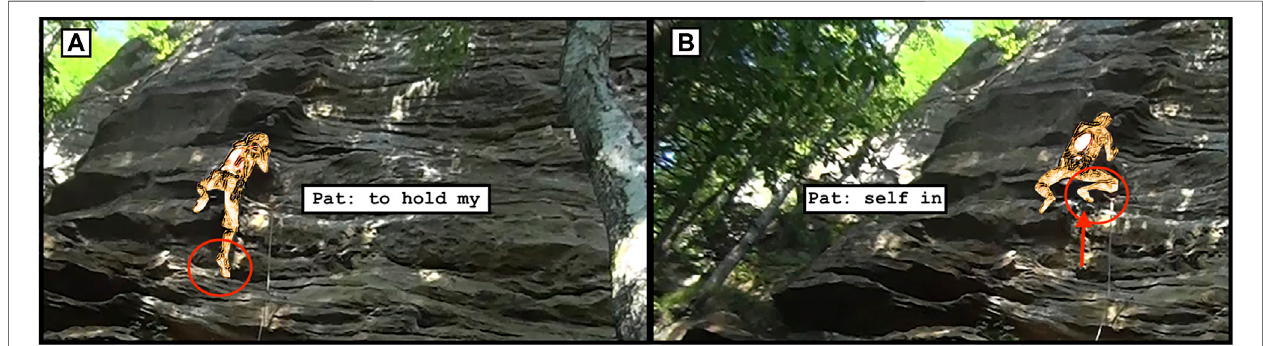
FIGURE 2 | As Pat lifts his foot, he suspends the ongoing word (or noun phrase), completing it (de fi nitively making it a word) once his foot is secure. The fi gure shows the difference in position from the opening moment of suspension (A) to the moment of resumption (B) . If the reader attempts this movement (put one leg half bent on a chair, try to stand up without kicking off, and have someone around to prevent falls), they will fi nd they tense many torso muscles as they lift their second leg and foot into the crouch and may hold their breath, especially if they are unstable.